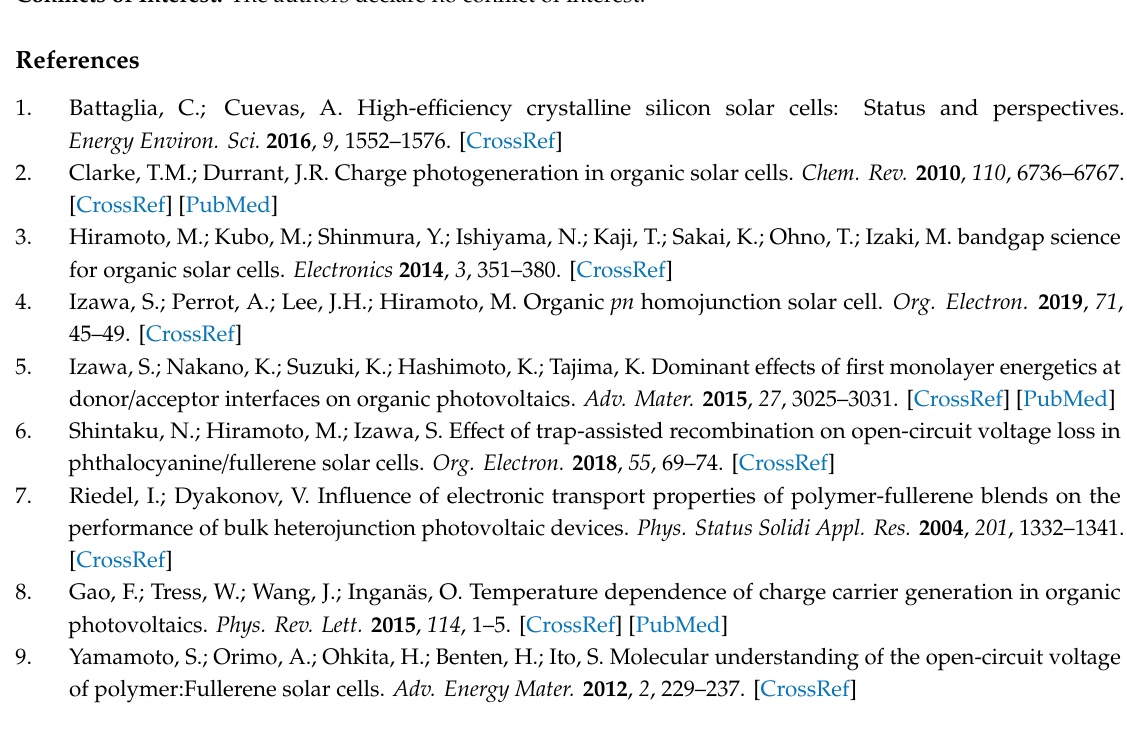
Figure S1: chemical structure, schematic of the device, energy levels; Figure S2: J–V curves; Figure S3: EQE and absorption spectra; Figure S4: WF as a function of the thickness; Figure S5: PYS spectra; Figure S6: light intensity dependence of J SC Table S1: summary of the device